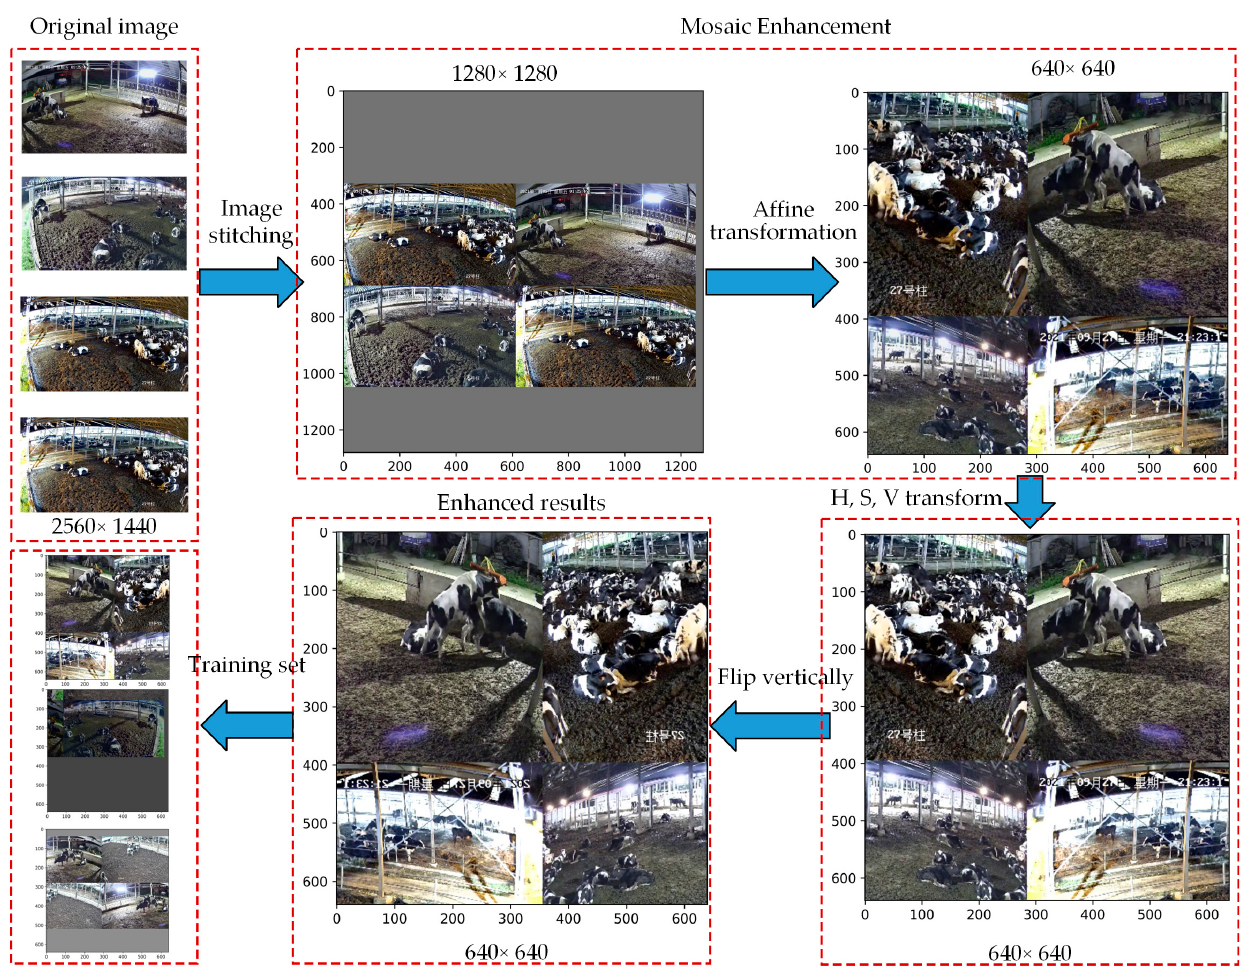
Figure 2. Training set enhancement process.